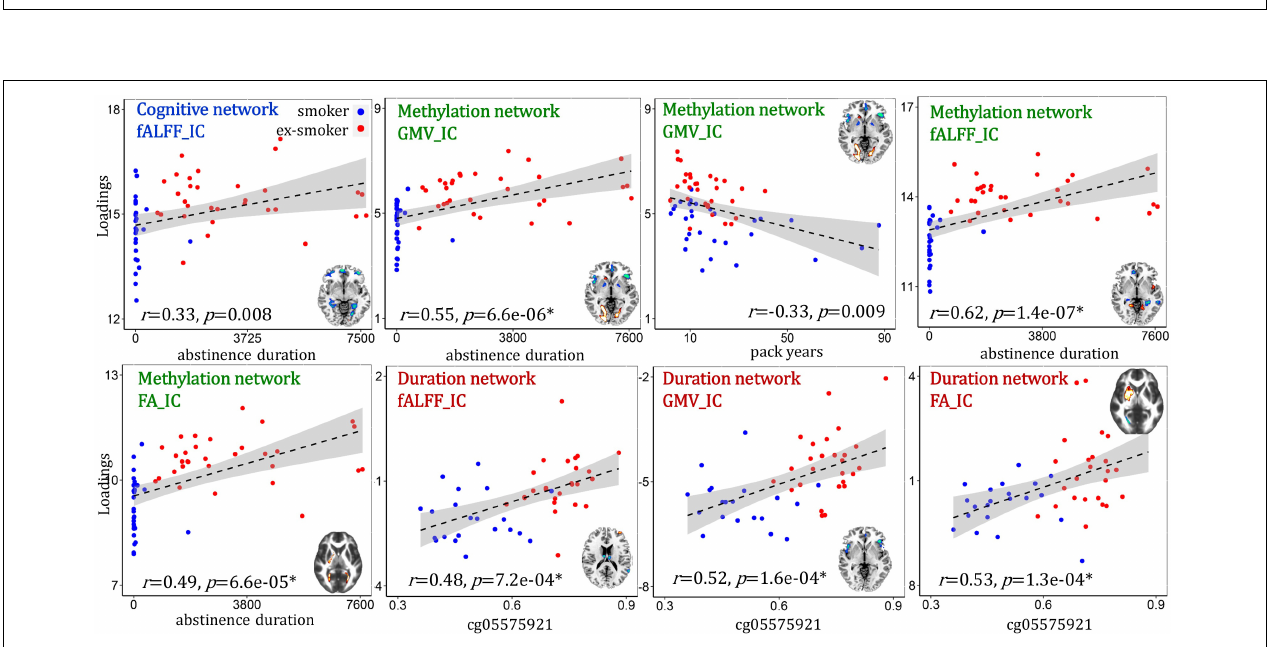
FIGURE 4 | Abstinence duration-associated fALFF + GMV + FA multimodal joint components. (A) The spatial brain independent component (IC) networks visualized at |Z| > 2.5. Regions where smokers > ex-smokers indicated by blue color, regions where ex-smokers > smokers indicated by red color. (B) Correlations between components’ loadings and abstinence duration. (C) Group difference of the components among smokers and ex-smokers.